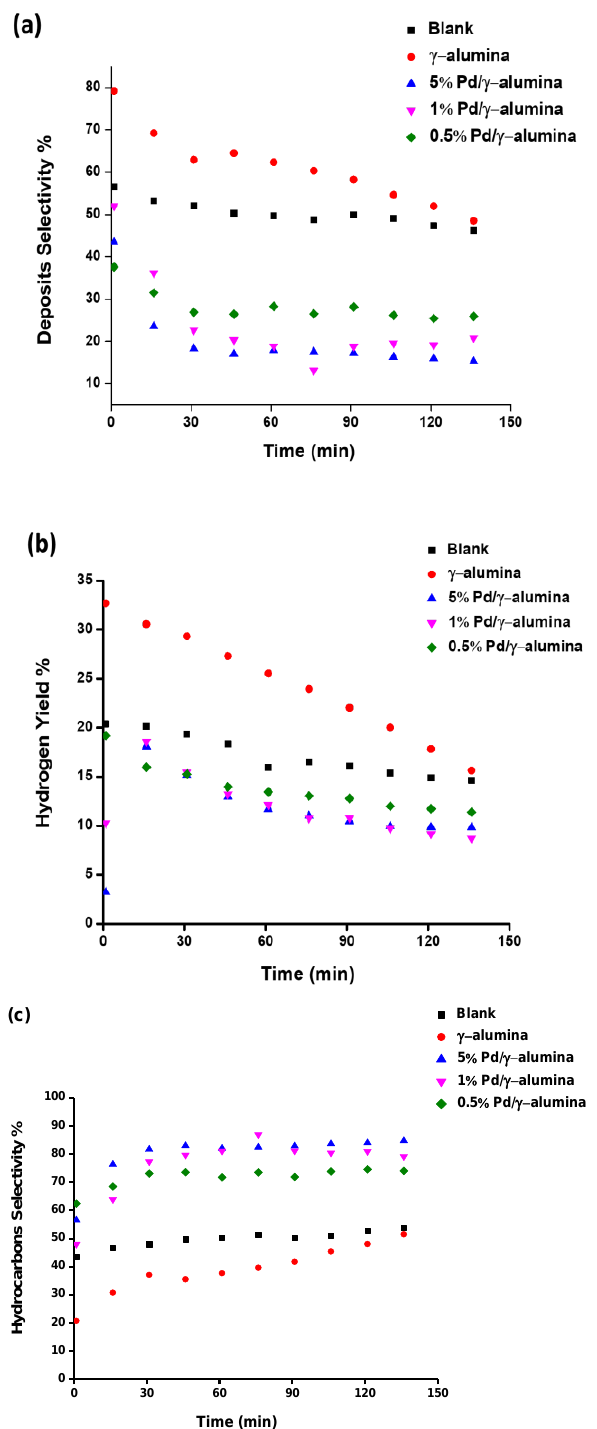
Figure 4. The e ff ect of packing the DBD plasma reactor with γ -alumina and Pd / γ -alumina with di ff erent loadings of Pd (0.5, 1, 5 wt%) on the DBD plasma reactor: ( a ) deposits selectivity, ( b ) hydrogen yield, ( c ) hydrocarbons selectivity.